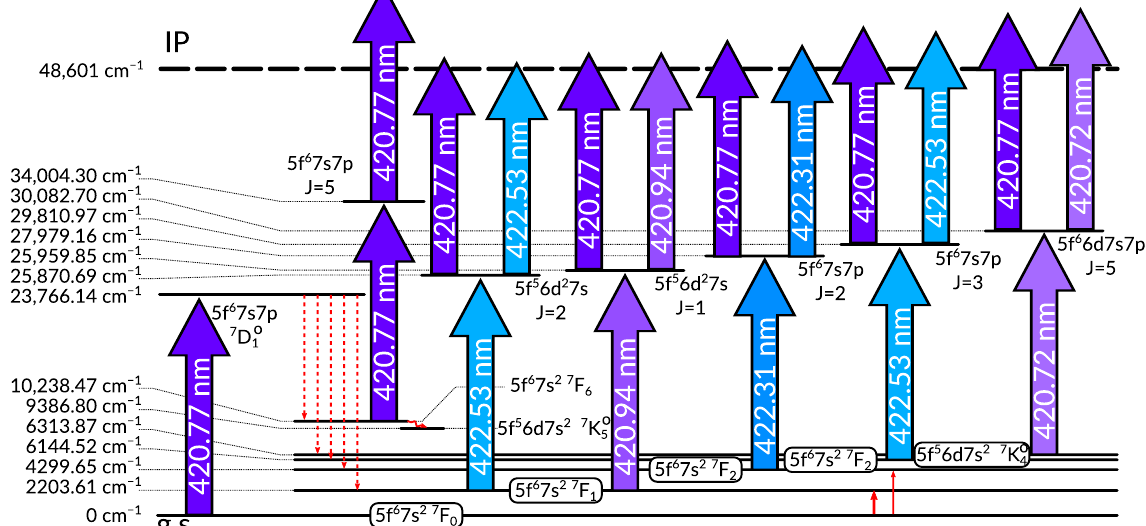
Figure 5. Plutonium atomic-level scheme developed with the grating-based Ti:Sapphire experiment. Thick arrows correspond to detected transitions, with the dashed arrows from the 7 D o senting the collisional de-excitation process to the low-lying states. The thin solid arrows starting from the atomic ground state indicate thermal excitation due to the hot